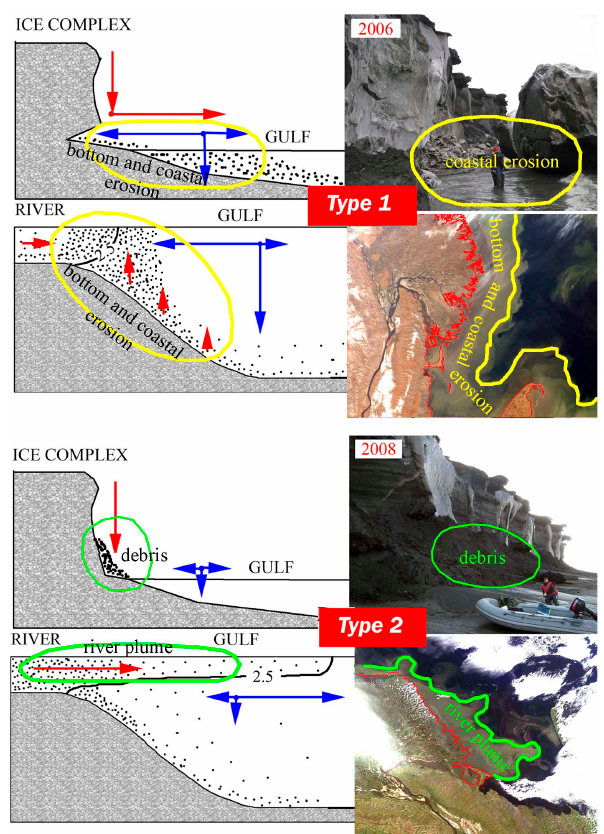
Fig. 10. Delivery scheme of sedimentary material from coastal ice- complex and mouths of the Lena River flow channels for two sedi- mentation regimes. Black points show concentration of sedimentary material, blue arrows show force and direction of movement of wa- ter, red arrows show intensity and direction of movement of flows of sedimentary material. Picture snapshots show northern coast of Muostakh Island at different sedimentation regimes. Satellite snap- shots feature flows of SPM under various regimes of